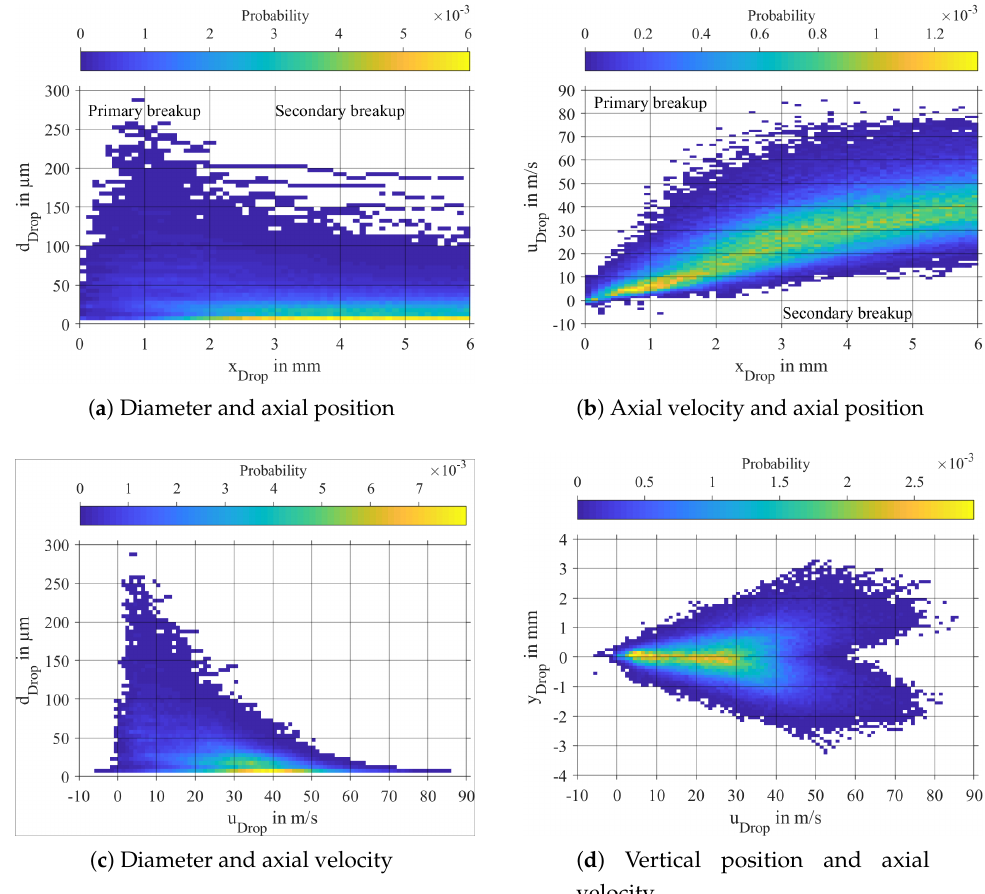
Figure 14. Interdependencies of spray quantities for p g = 5bar, u g = 70m/s, h a =